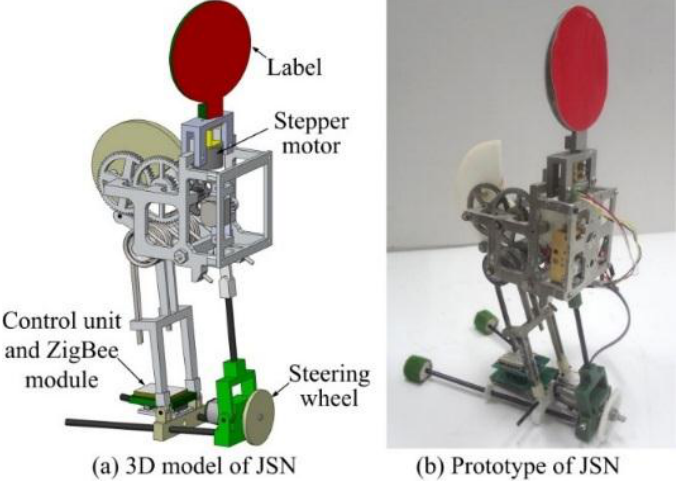
Figure 10. 3D model and prototype of the